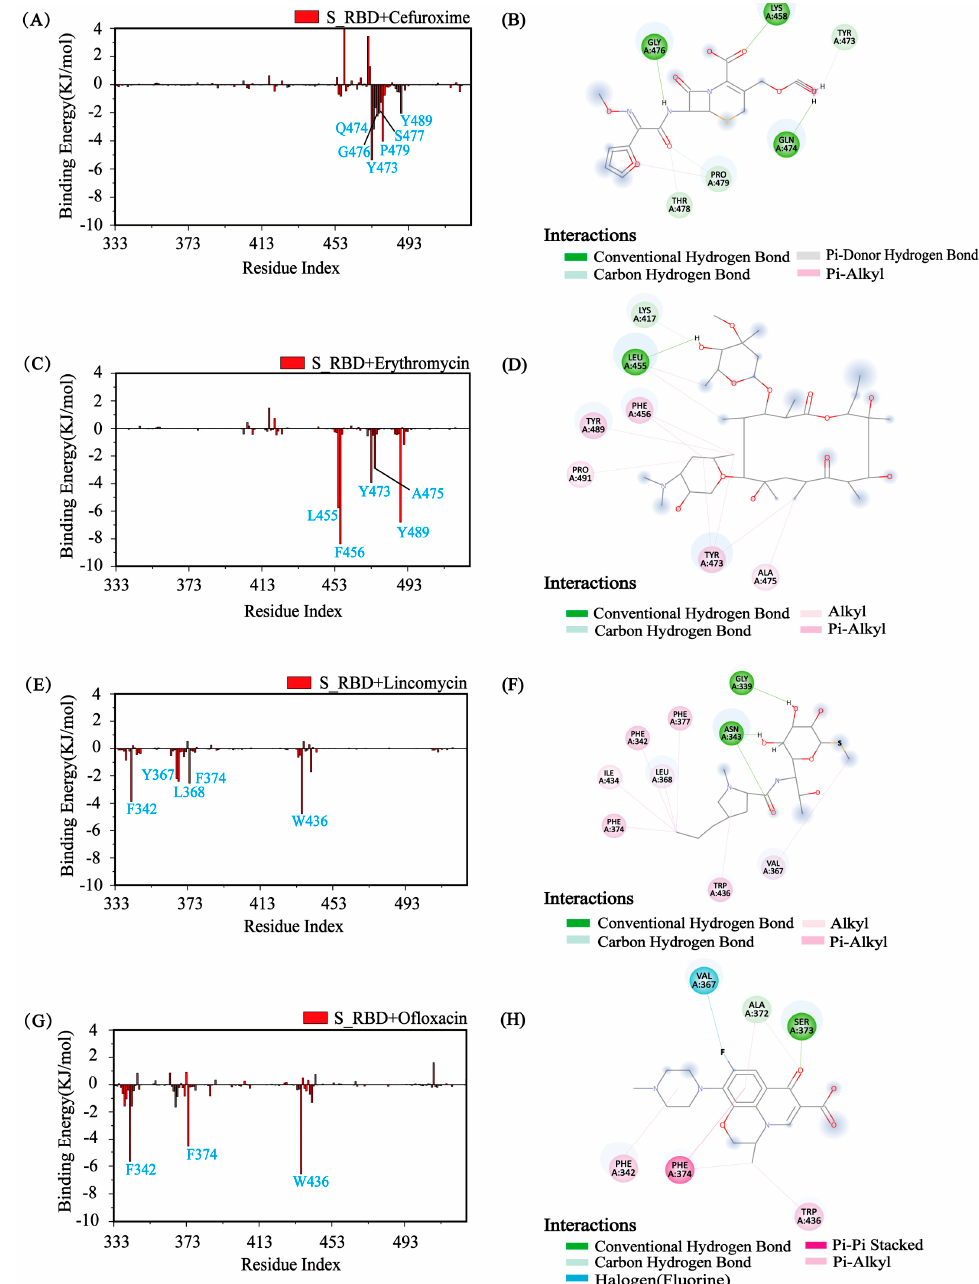
Figure 5. Residue-based interaction sites analysis. The binding free energy (in kJ/mol) between each residue of S_RBD and the inhibitors ( A , C , E , G ). The binding models between the inhibitors and S_RBD are described in details ( B , D , F , H ). The binding model is the most representative frame of each MD simulation. The inhibitors are shown as sticks using Discovery Studio. The types of interactions are the hydrophobic interactions (conventional hydrogen bond, alkyl interaction, pi-alkyl interaction and carbon hydrogen bond) and π - π interaction.